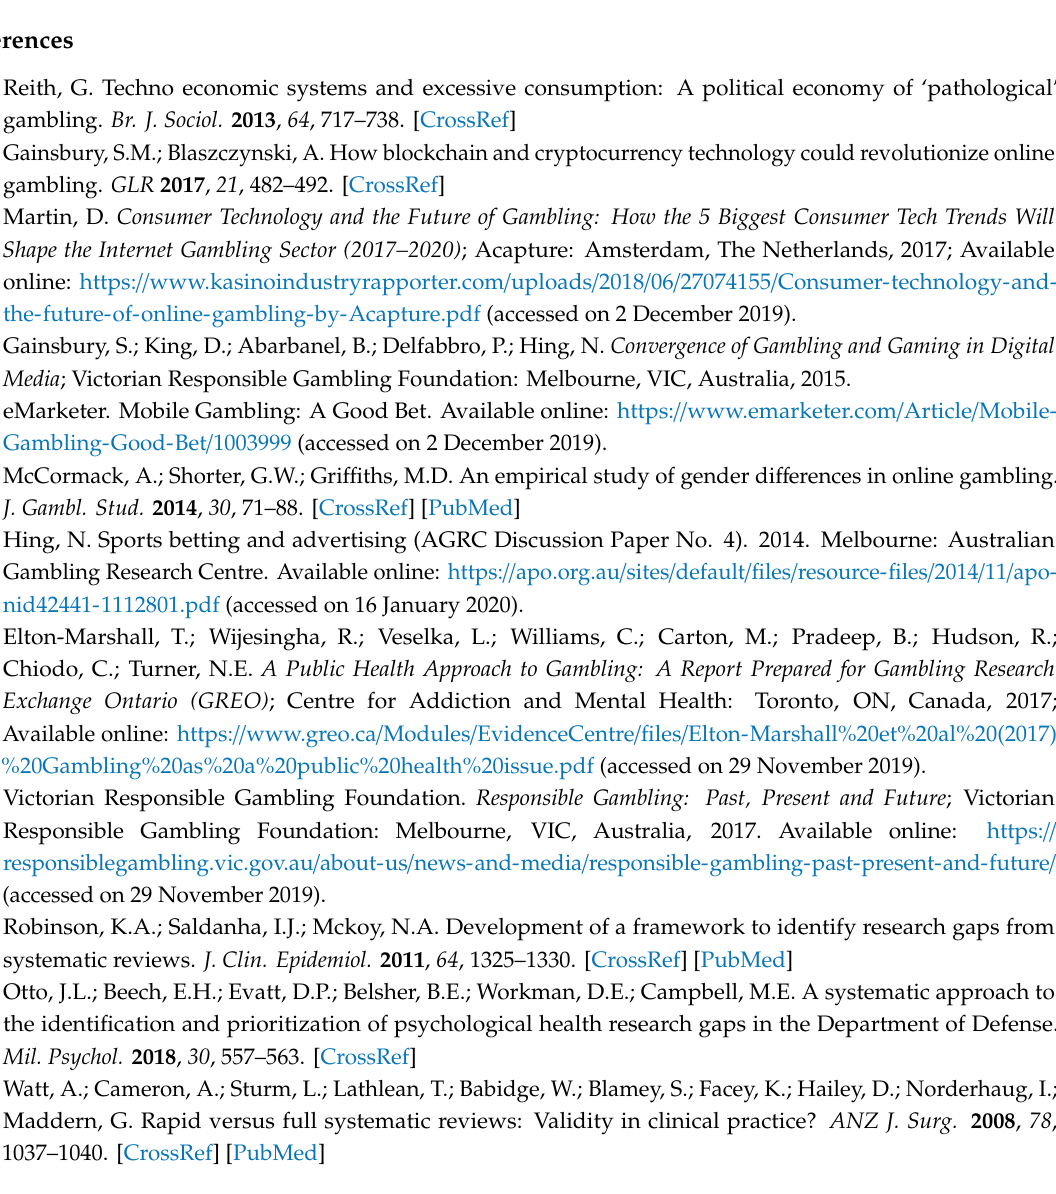
Ratings for Peer-reviewed Literature—Technology and Trends (Quant RCTs), Table S3: Quality Ratings for Peer-reviewed Literature—Technology and Trends (Quant Non-Randomised), Table S4: Quality Ratings for Peer-reviewed Literature—Technology and Trends (Quant Descriptive), Table S5: Summary of Internet gambling articles, Table S6: Summary of articles on video gaming and gambling, Table S7: Summary of articles on the expansion of the sports betting market, Table S8: Summary of articles on electronic gaming machines (EGMs), Table S9: Summary of articles on advertising and